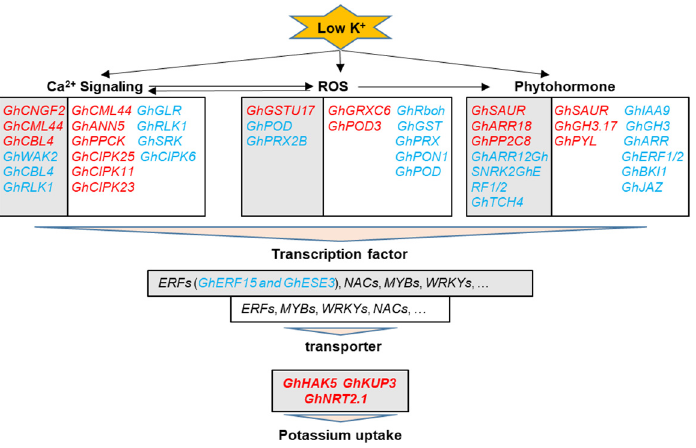
Figure 9. A model of transcription regulation involved in response to potassium (K + ) deficiency and feedback regulation of K + uptake and root growth in cotton. Genes within the light grey box show the same responses to low K + stress in CCRI41 (a K + inefficient cotton variety) self-grafts (CCRI41/CCRI41, scion/rootstock) and its reciprocal grafts (SCRC22/CCRI41) with SCRC22 (a K + ef- ficient variety); while genes within the white box represent the components involved in feedback regu- lation of K + uptake and root growth under K + deficiency, they were specifically identified in the roots of SCRC22/CCRI41 or oppositely regulated by low K + in CCRI41/CCRI41 and SCRC22/CCRI41. The red and blue highlighted genes were up- and down-regulated by low K +